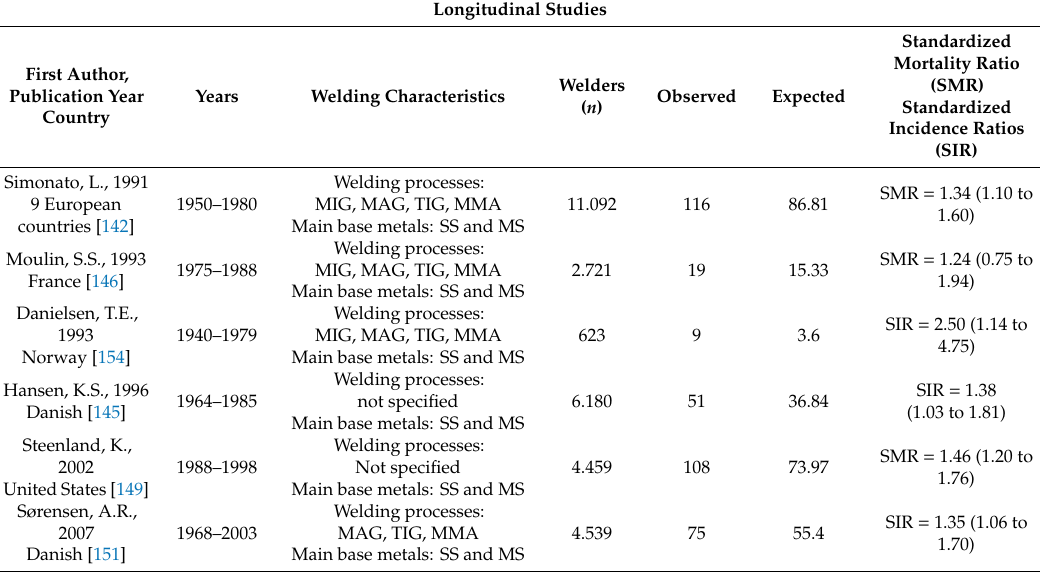
Table 4. Risk for lung cancer in welders. Standardized mortality ratio (SMR) and standardized incidence ratio (SIR): 95% confidence interval.